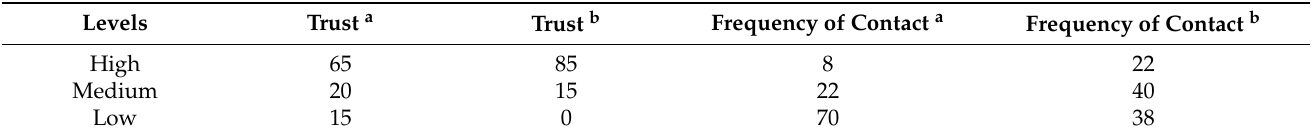
Table 4. Existing relationships prior to the SI process (in percentages). Own elaboration based on the analysis of the structured questionnaire (2nd phase). ( a ) Before the SI process; ( b ) during the SI process.